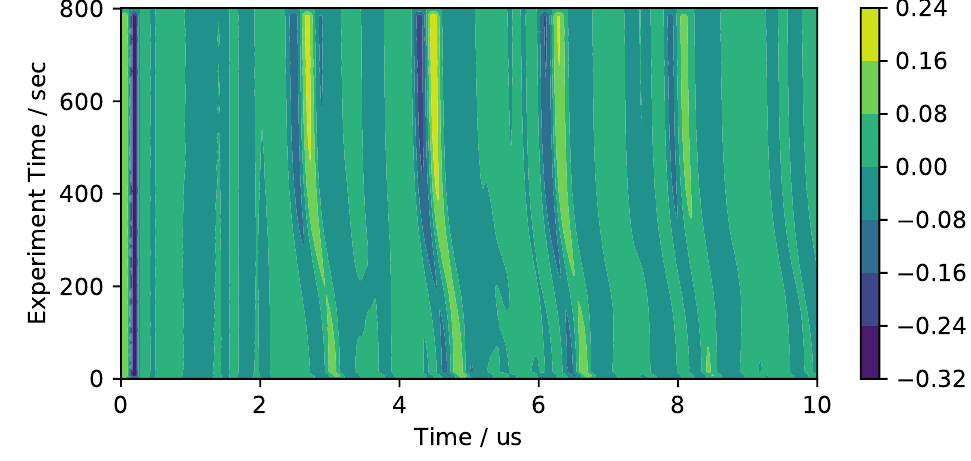
Figure 6. Colored contour diagram of the received signal during experiments on a large cross